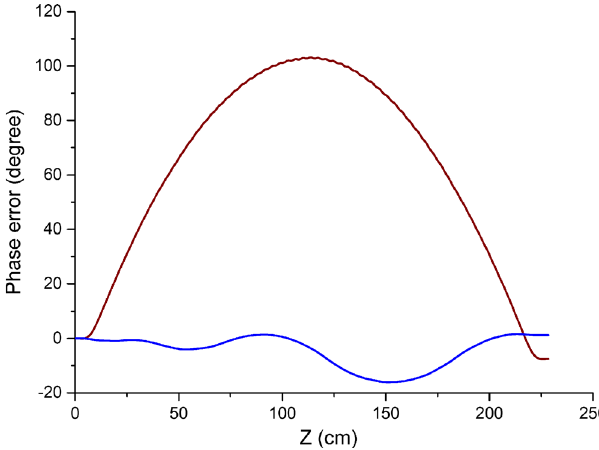
FIG. 15. Period averaged phase error (red: first step; blue: after 20